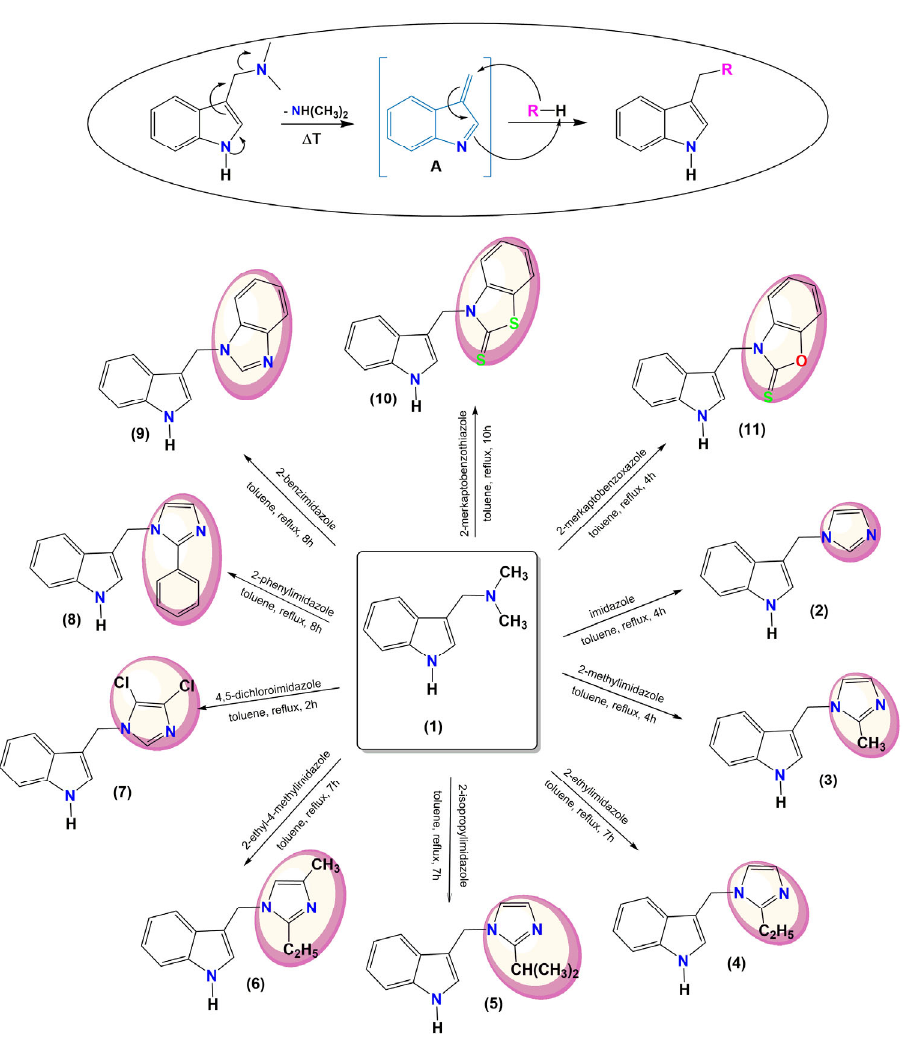
Figure 2. Synthesis of indole derivatives with imidazole, benzothiazole–2–thione and benzoxazole–2–thione moieties.